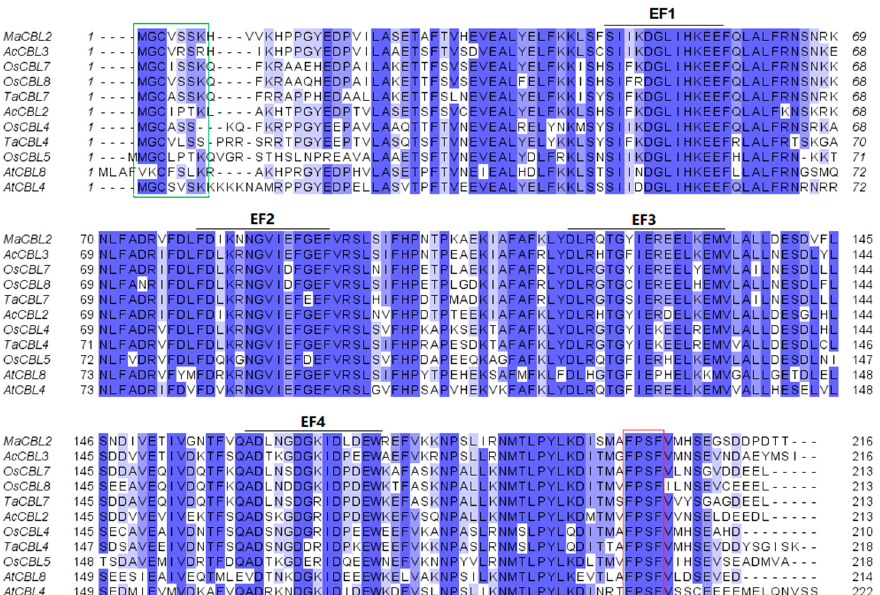
Figure 5. Multiple sequence alignment of MaCBL2 and other CBLs from other species. The blue shadow indicates similarity at ≥ 50%. The black lines indicate the elongation factor hand (EF-hand) domains. The green box indicates the myristoylation site, and the red box indicates the FPSF motif.